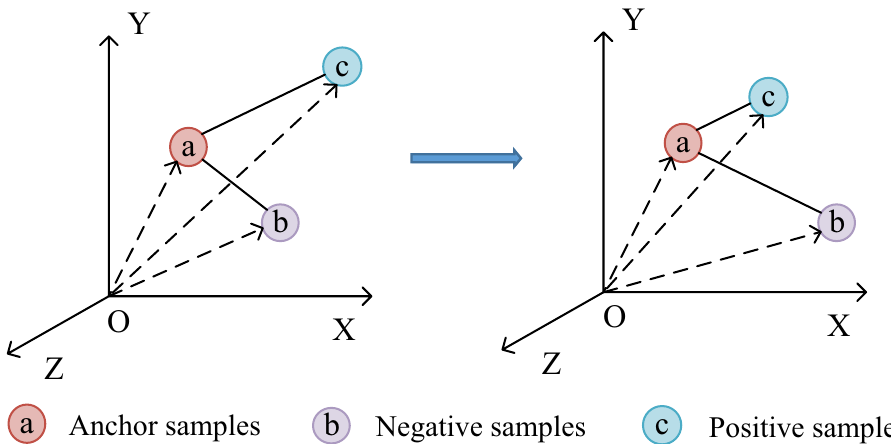
Figure 5. Triangle Area Triplet Loss Function for training, TA is adopted as sample distance measurement. (Created by ‘Microsoft Office Visio 2013’ https:// www. micro soft. com/ zh- cn/ micro soft- 365/ previ ous- versi ons/ micro soft- vision-